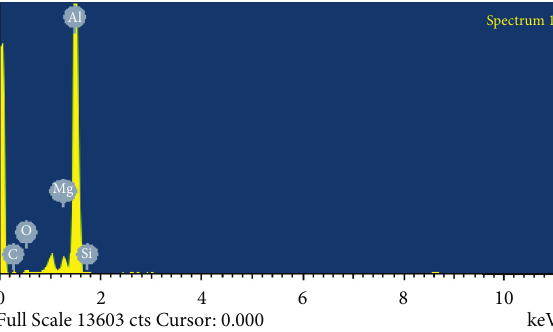
Figure 4: EDAX graph of Al 7075 95% and TiB